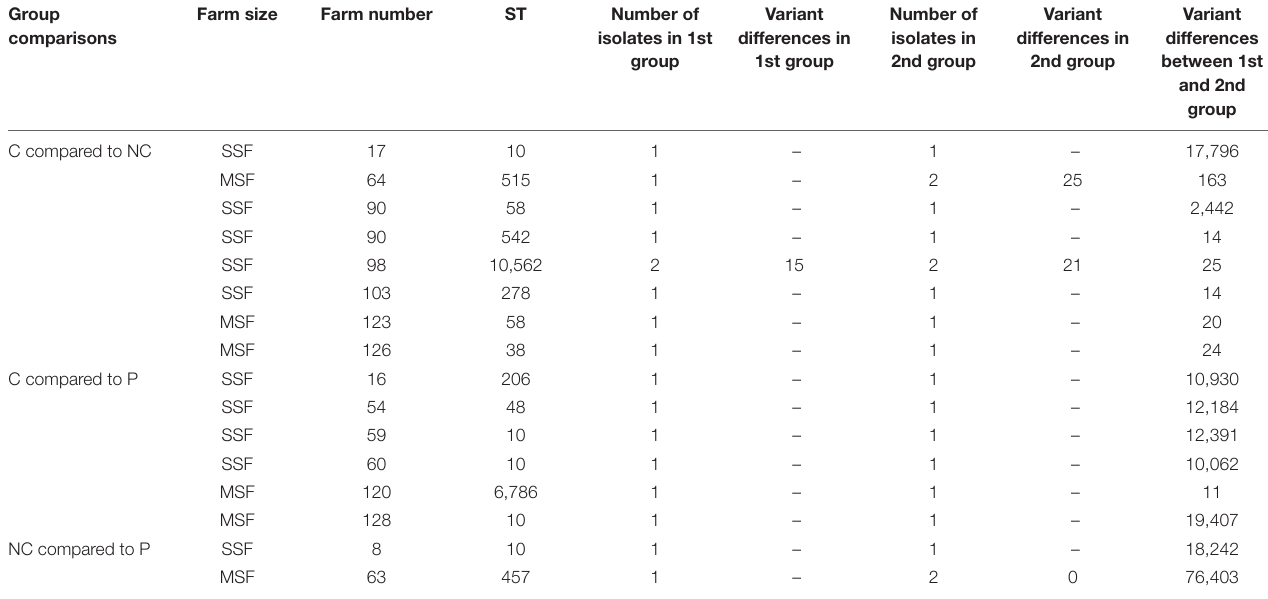
TABLE 4 | Variant differences between groups with matching